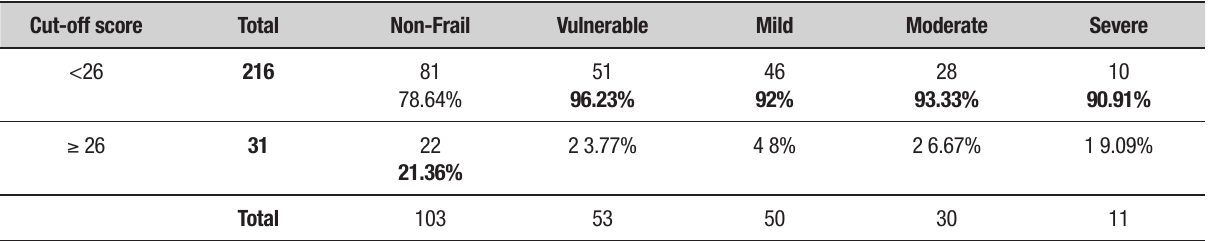
Table 2. Comparison of level of frailty according to the EFS for cut-off score on the MoCA of elderly registered at CRAS. São Carlos, SP, 2016 (n=247). Cut-off score Total Non-Frail Vulnerable